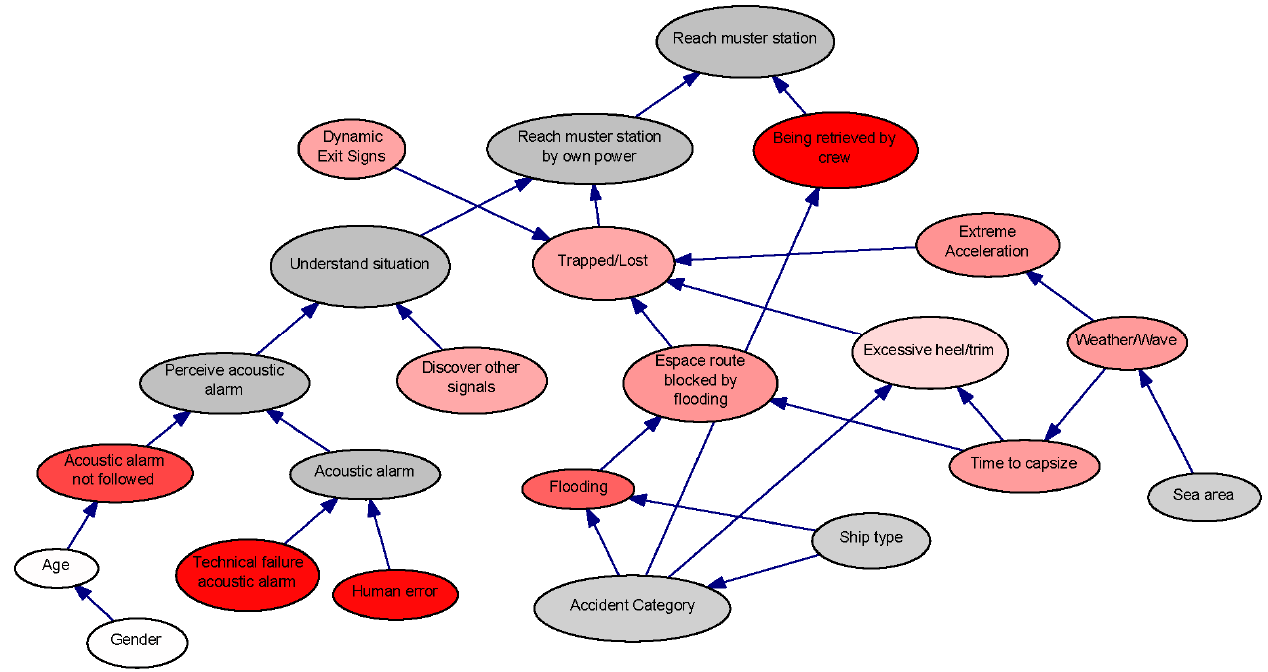
Figure 8. A Bayesian network for the mustering process, including Dynamic Exit Signs, with “Reach Muster Station” as the target parameter for the sensitivity analysis (accident category = collision, ship type = cruise, and sea area = worldwide).